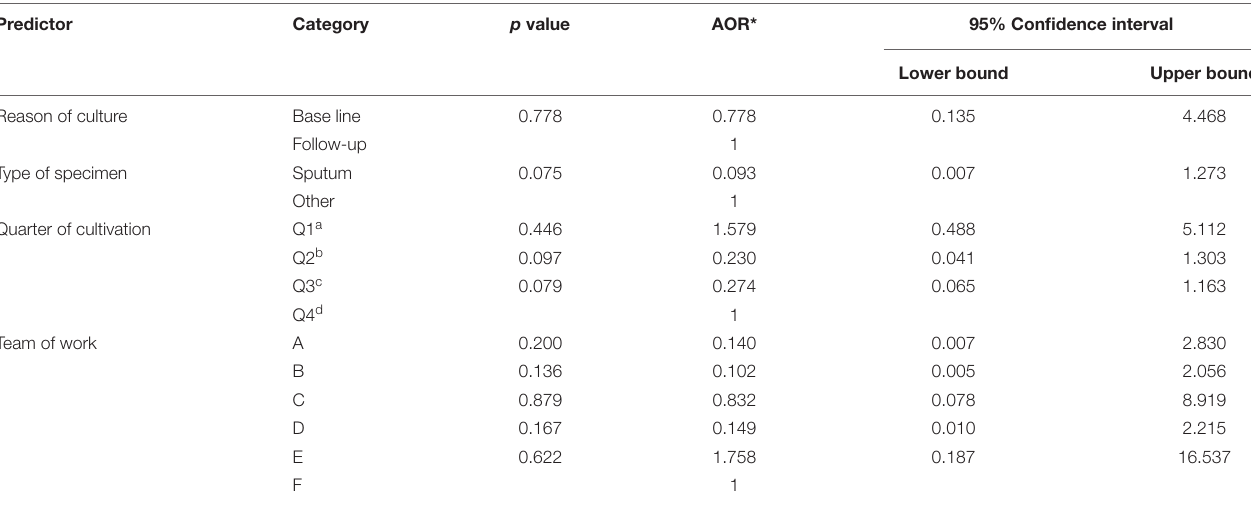
TABLE 4 | Multivariate logistic regression of massive culture